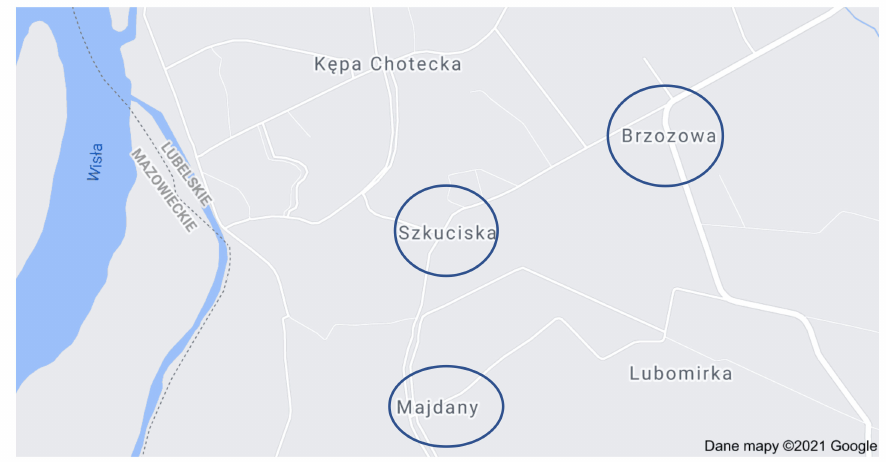
Figure 5. Research